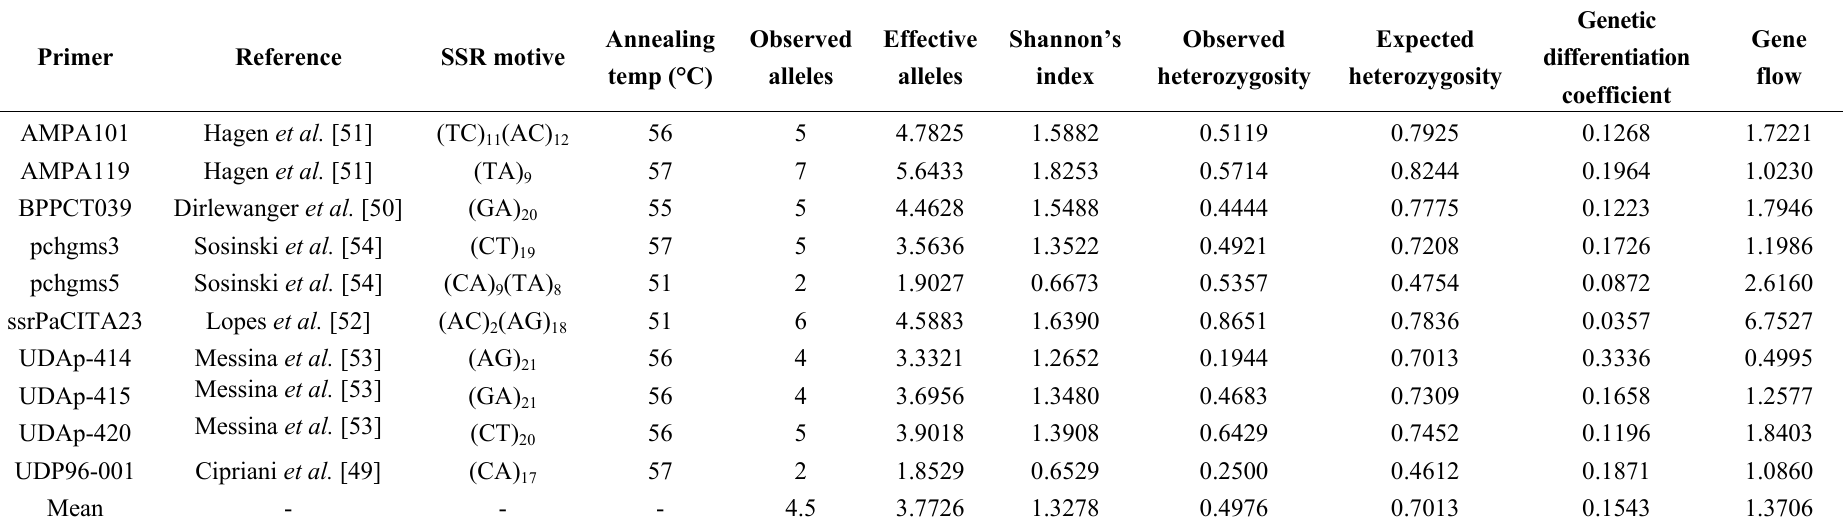
Table S2. List of SSR primers and Genetic diversity parameters for the genotypes